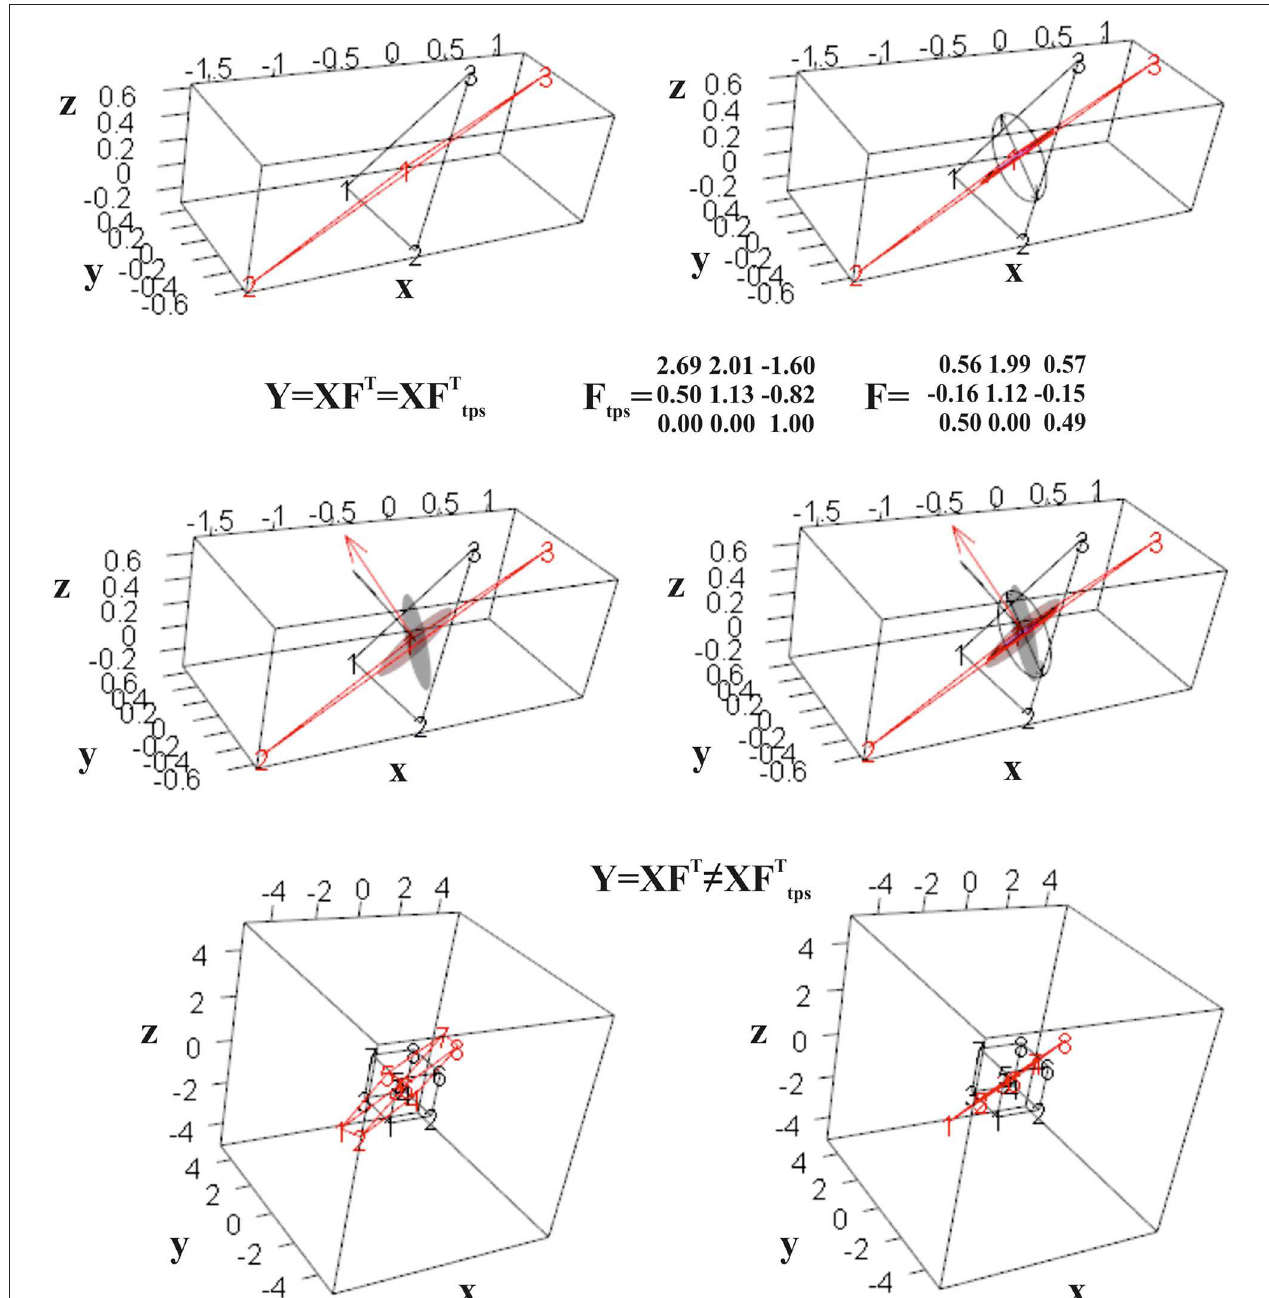
FIGURE 7 | Computation of F for two triangles in R 3 . Top row : the undeformed black triangle is deformed into the red one; the direct computation leads to a tensor that flattens a unitary sphere in an ellipse in R 3 . Mid row : F tps deforms a unitary sphere into an ellipsoid. Both F and F tps return the deformed state if used to deform the source triangle. Bottom row : when applied to a regular cube, only F deforms it into a flat shape, while it does not hold for F tps .